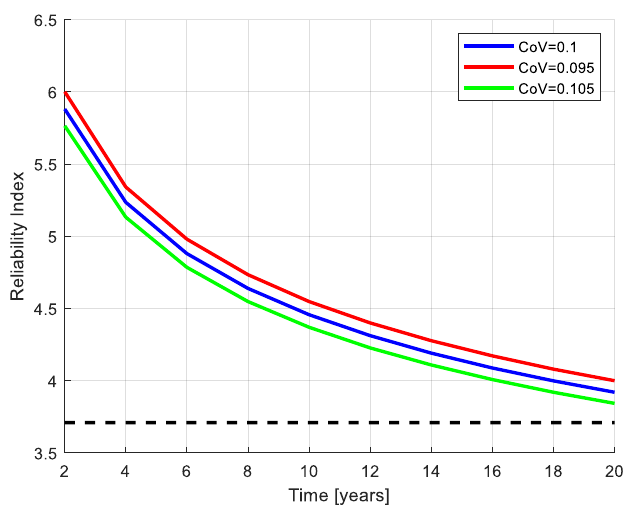
Figure 11. Fatigue reliability index with different coefficients of variation (COVs).